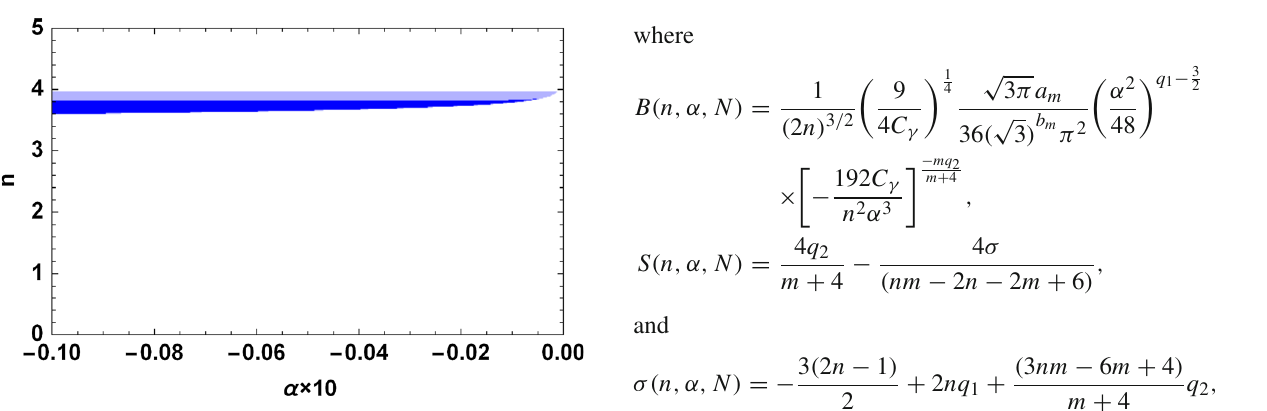
Fig. 5 The ranges of the parameters ( n ,α) of the chameleon field driven warm inflation model in the strong dissipative regime that are consistent with n s and r located in the observational area. The light blue color indicates the areas with 95% CL, while the dark blue color indicates the areas with 68% CL